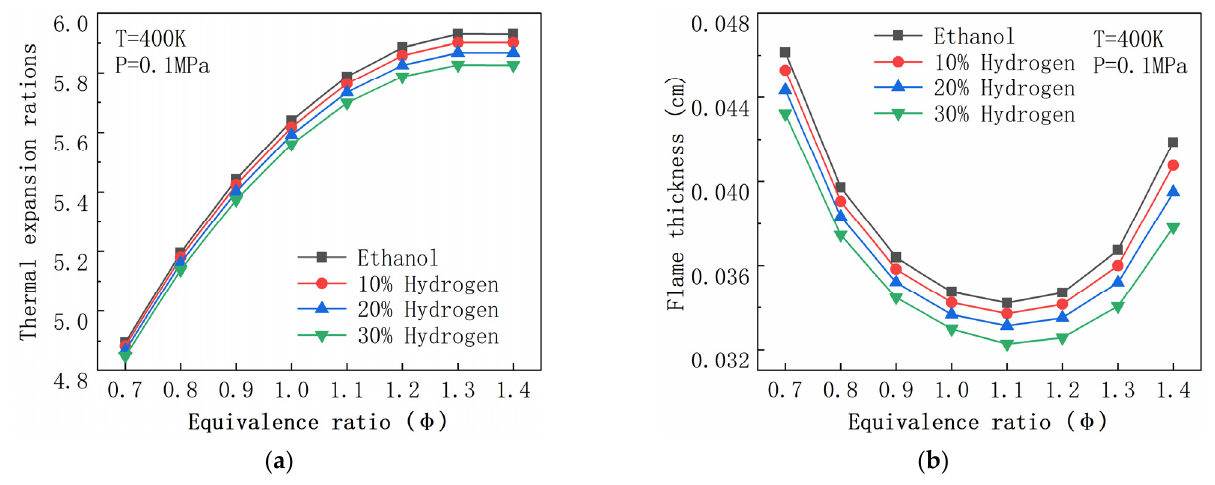
Figure 11. The laminar flame thickness ( δ ) and thermal expansion ratios ( σ ) of ethanol–hydrogen–air flames. ( a ) Thermal expansion ratios ( σ ). ( b ) The laminar flame thickness ( δ ).